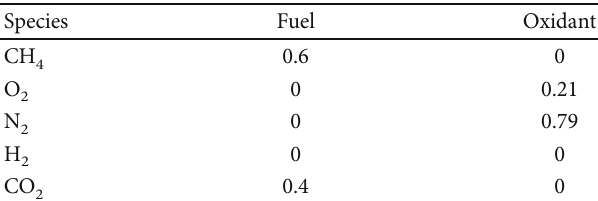
Table 3: PDF for boundary conditions.